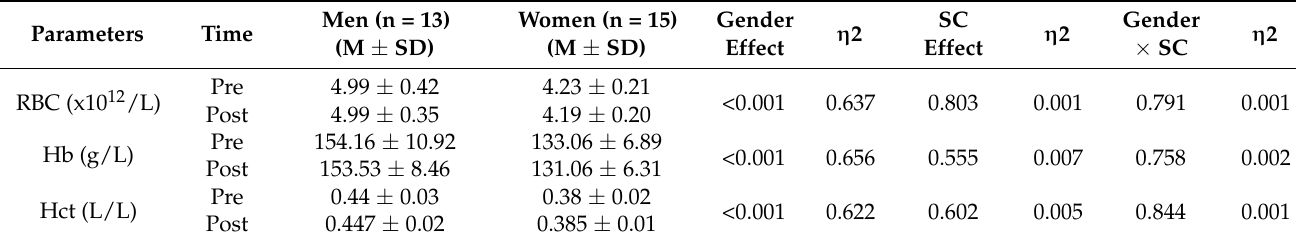
Table 6. The participants’ hematological